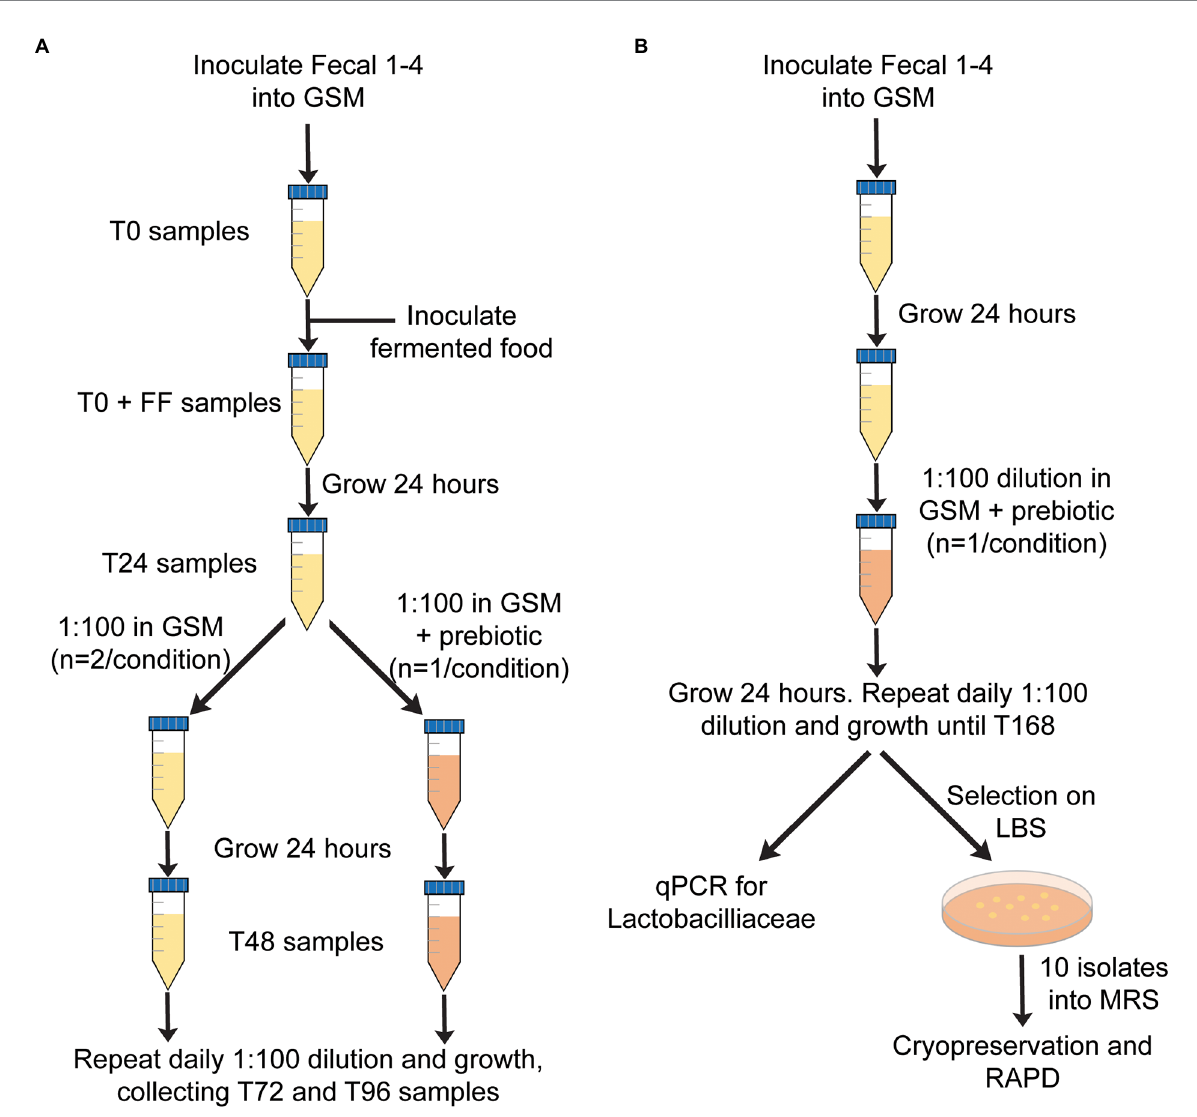
FIGURE 1 Overview of in vitro fecal culture experimental design. (A) Approach used to test the persistence of FAB over time (0–96 h) in the presence or absence of prebiotics. (B) Approach used to test whether prebiotics would enhance the growth of autochthonous